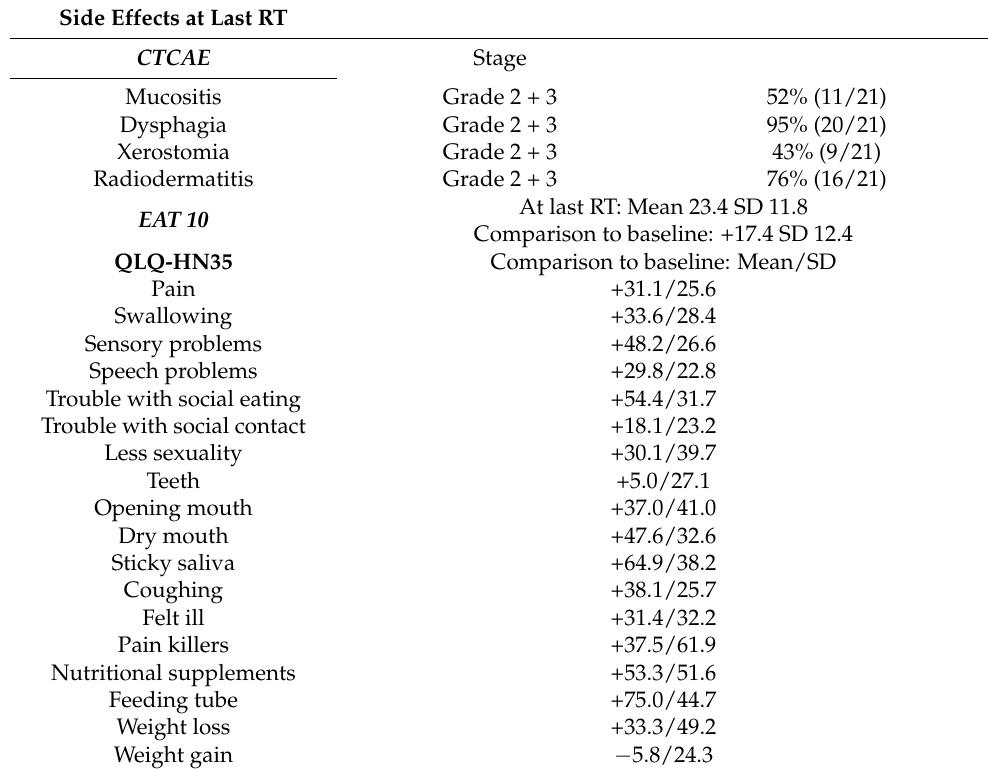
Table 3. Side effects at last